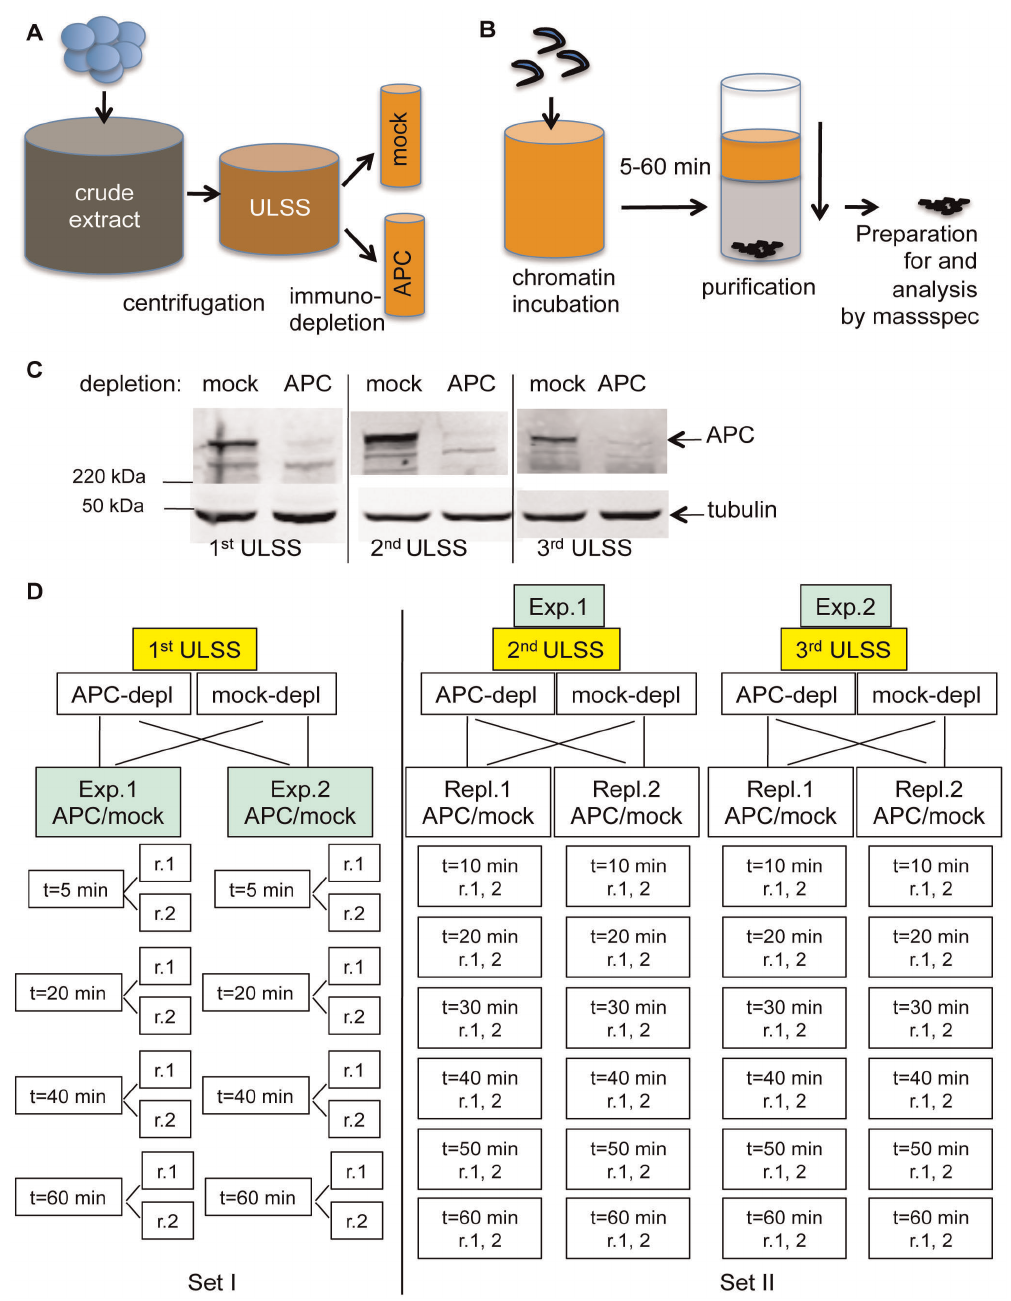
Figure 3. Experimental layout for proteomic analysis of chromatin-associated proteins in APC-depleted and mock-depleted Xenopus extract. A . Schematic representation of extract preparation. CSF (crude) extract obtained from Xenopus eggs was spun as in Methods, and a clear golden fraction was collected (ULSS extract). It was then incubated for 1 h with Dynabeads loaded either with affinity purified APC-specific antibody or non-specific rabbit IgG in the same concentration. Antibody-bound Dynabeads were magnetically retrieved, and the depleted extracts were used in the experiment. B . Schematic representation of chromatin manipulation in the experiment. Demembranated chromatin was added to the extract at concentration 20 ng per 1 m l of extract, mixed and incubated for indicated length of time (as in D.) before isolation by centrifugation through 30% sucrose cushion. After several washes chromatin was trypsinised and processed for mass spectrometry as described in Materials and Methods. C. Level of APC depletion in three extract preparations used in proteomics screen visualized by immunoblotting with anti-APC antibodies (APCII) and anti-tubulin antibodies as a loading control. 1 m l of corresponding extract were loaded into each lane and separated on PAGE prior immunoblotting. D . Experimental layout. In the 1 st set (left), mock- and APC-depleted 1 st ULSS extract were each separated into two halves and analysed as two technical replicas (exp. 1 and exp 2). Chromatin incubated for 5, 20, 40 or 60 min in these extracts was isolated as in B., and analysed by mass-spectrometry twice for each point (r.1 and r.2). In the 2 nd set, two independently derived and immunodepleted extracts (2 nd and 3 rd ULSS) were used in two identically performed experiments. Within each experiment, both APC and mock-depleted extract were separated into two halves (repl.1 and repl.2) and each was incubated with chromatin for 10, 20, 30, 40, 50 or 60 min. Chromatin associated peptides were measured with two different settings for each point, producing one extended measurement. (r.1, 2).